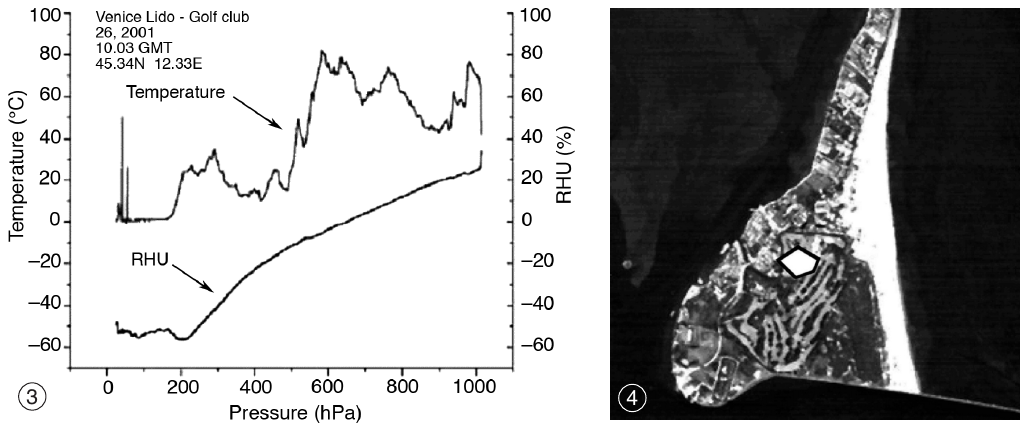
Fig. 3. Meteorological parameters profile, temperature and RHU (relative humidity) obtained with radiosound- ing balloon. Fig. 4. Selected portion of interest (516 pixels) over radiosounding launched area (Malomocco, Lat: 45°72 l N; Long: 12°52 l W) into the nadir direction. The polygon is defined to apply the statistics of water vapor estimat- ed by spectral-based